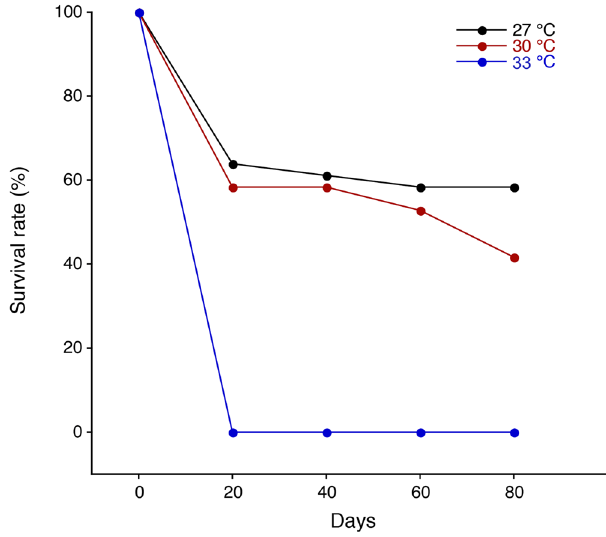
Figure 3: Survival rates of postlarvae in the giant freshwater prawn Macrobrachium rosenbergii reared in di ff erent temperature regimes of 27°C ( black ) , 30°C ( red ) , and 33°C ( blue ) .